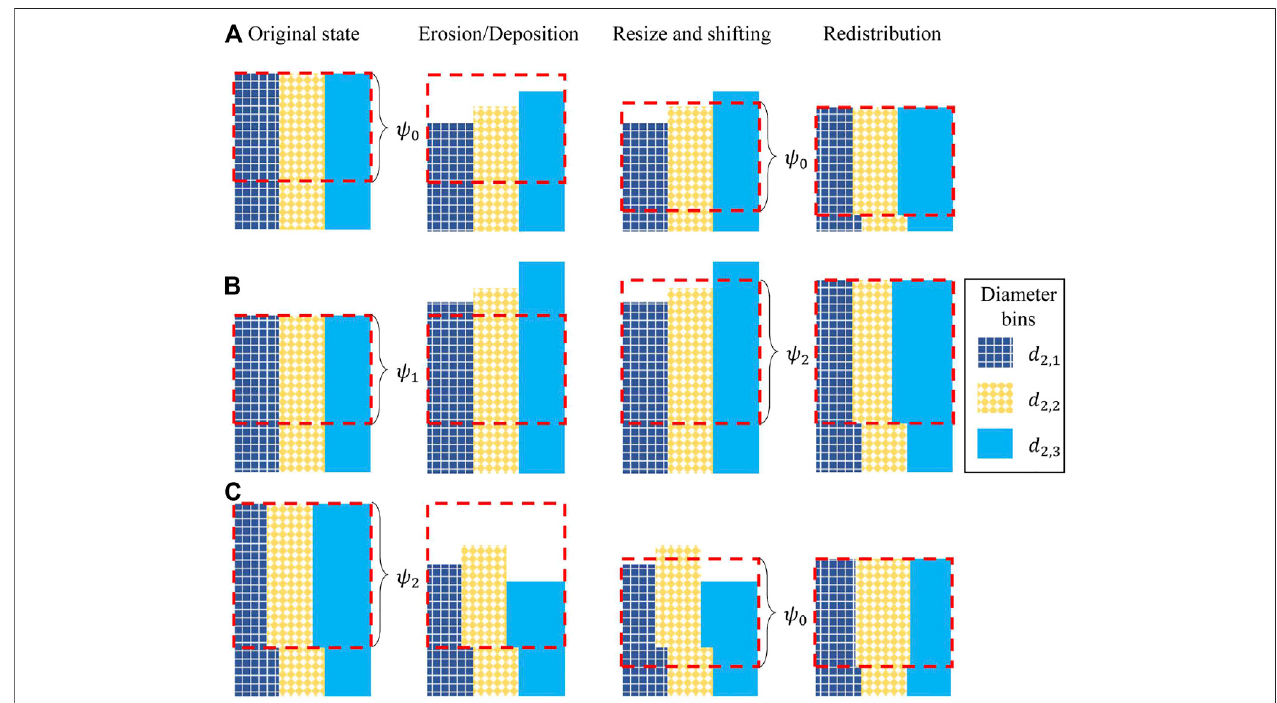
FIGURE 3 | Demonstration on the surface diameter change of one subregion. The bars with different colors represent the fi ctitious diameter bins containing particles with a certain size. (A) The affectable layer with a smallest affectable depth ψ 0 has been eroded. The affectable layer moves downward and obtains particles from the lower bed. (B) Deposition happens at the affectable layer with an affectable depth ψ 1 . The size of the affectable layer stretches. (C) Erosion happens at a stretched affectable layer. According to the eroded volume, the affectable layer will resize or move downward.